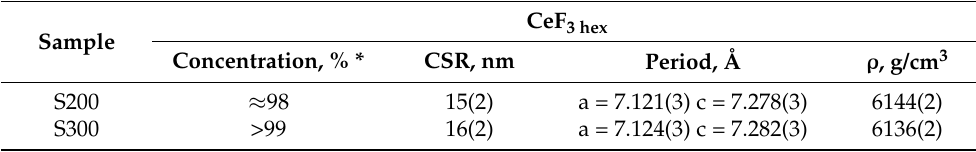
Table 1. Crystal lattice parameters and CSR dimensions of the hexagonal-phase CeF 3 in annealed samples of S200 and S300.